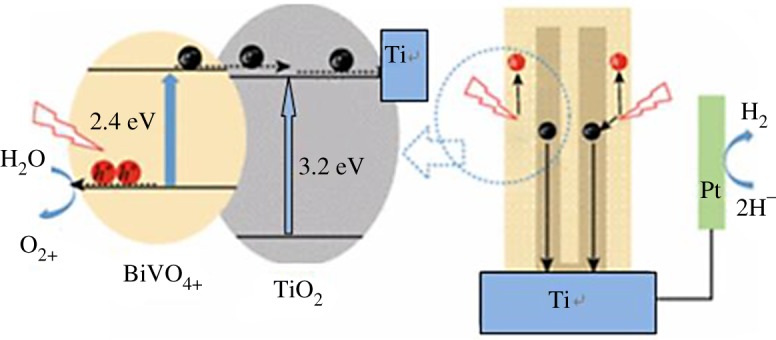
Schematic of energy bands and charge transfers at BiVO4/TiO2/Ti film.